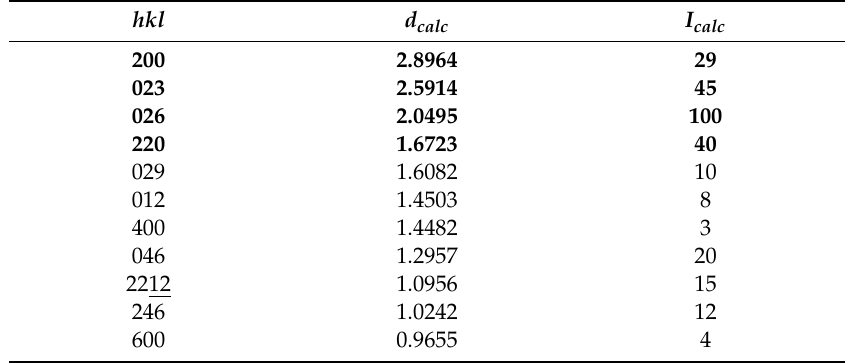
Table 5. Calculated X-ray powder di ff raction data (d in Å) for eliopoulosite. The strongest observed reflections are given in